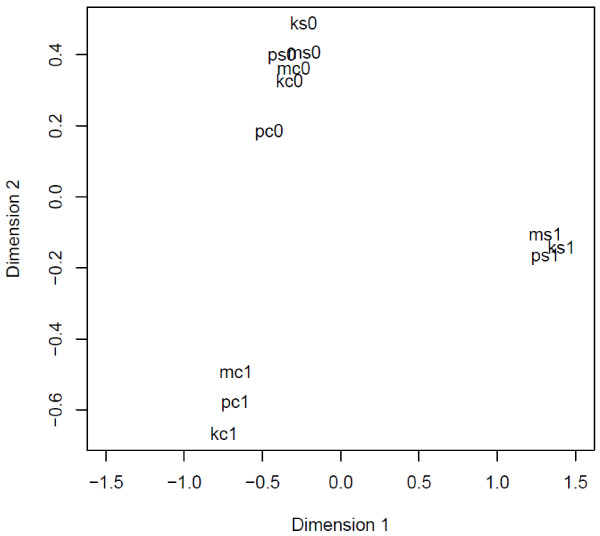
Multi-dimensional scaling (MDS) plot of gene expression of 12 RNA-seq libraries. S0 and C0 were samples collected at the beginning of the treatment. Control samples (C1) and stressed samples (S1) collected at the end of the treatment; K = Katherine, P = Petford, M = Mount Isa.